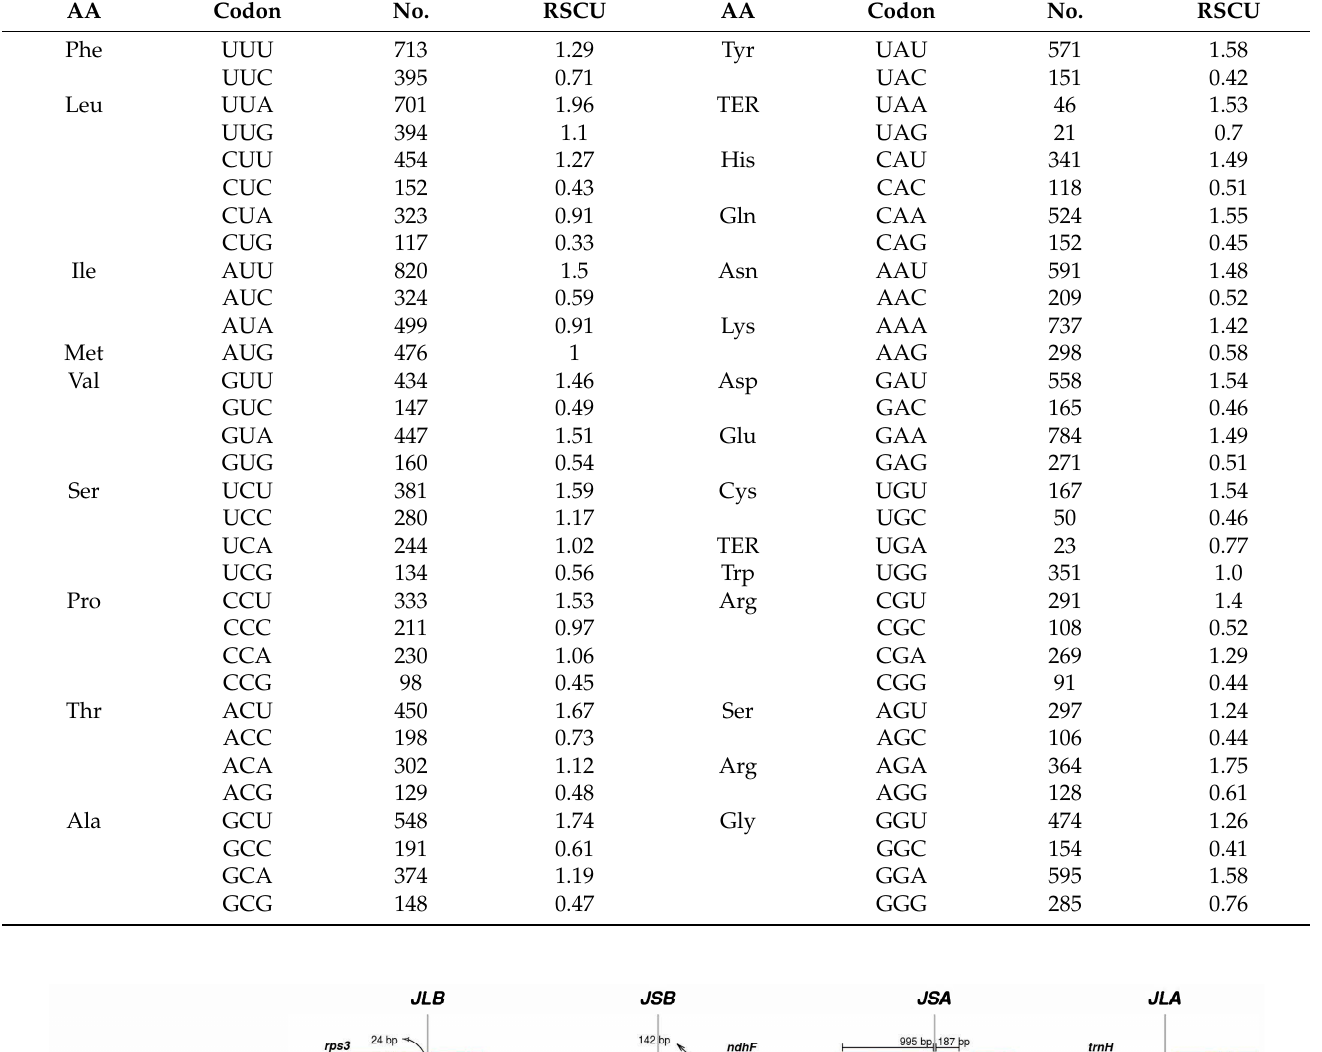
Table 2. Comparative analysis of chloroplast codon usage bias of Indosasa lipoensis .